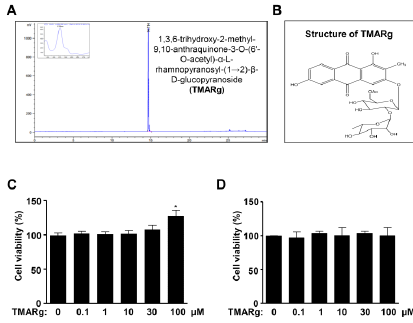
Figure 1. Effects of TMARg regarding cell toxicity in pre-osteoblasts. ( A ) HPLC chromatogram of 1,3,6-trihydroxy-2-methyl-9,10-anthraquinone-3- O -(6′- O -acetyl)-α- L -rhamnopyranosyl-(1 → 2)-β- D -glucopyranoside (TMARg) isolated from the roots of Rubia cordifolia . ( B ) Chemical structure of TMARg. ( C , D ) TMARg was used for the treatment of pre-osteoblasts (C) and C2C12 (D) at concentrations of 0.1, 1, 10, 30, and 100 µ M for 24 h. Cell viability was measured by using the MTT assay. The data are representative of the results of three independent experiments. Data represent the means ± SEMs of the experiments. *, p < 0.05 was considered significantly di ff erent compared to the